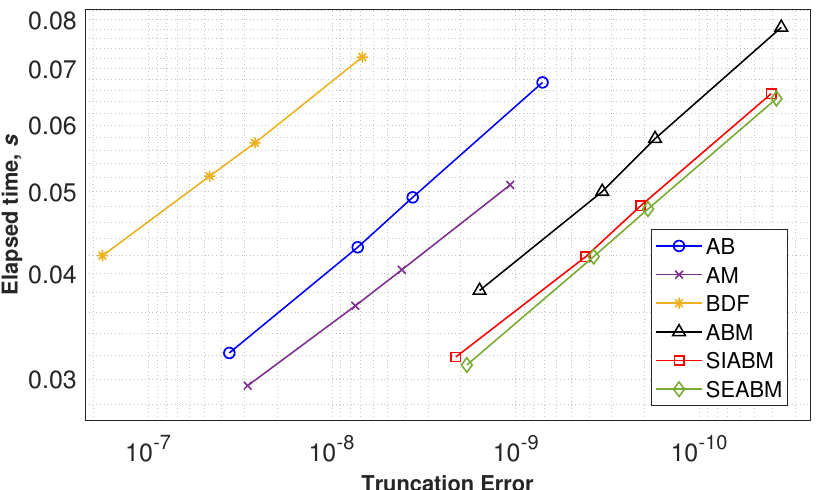
Figure 2. Performance plots for compared multistep ODE solvers when simulating system (6) with variable